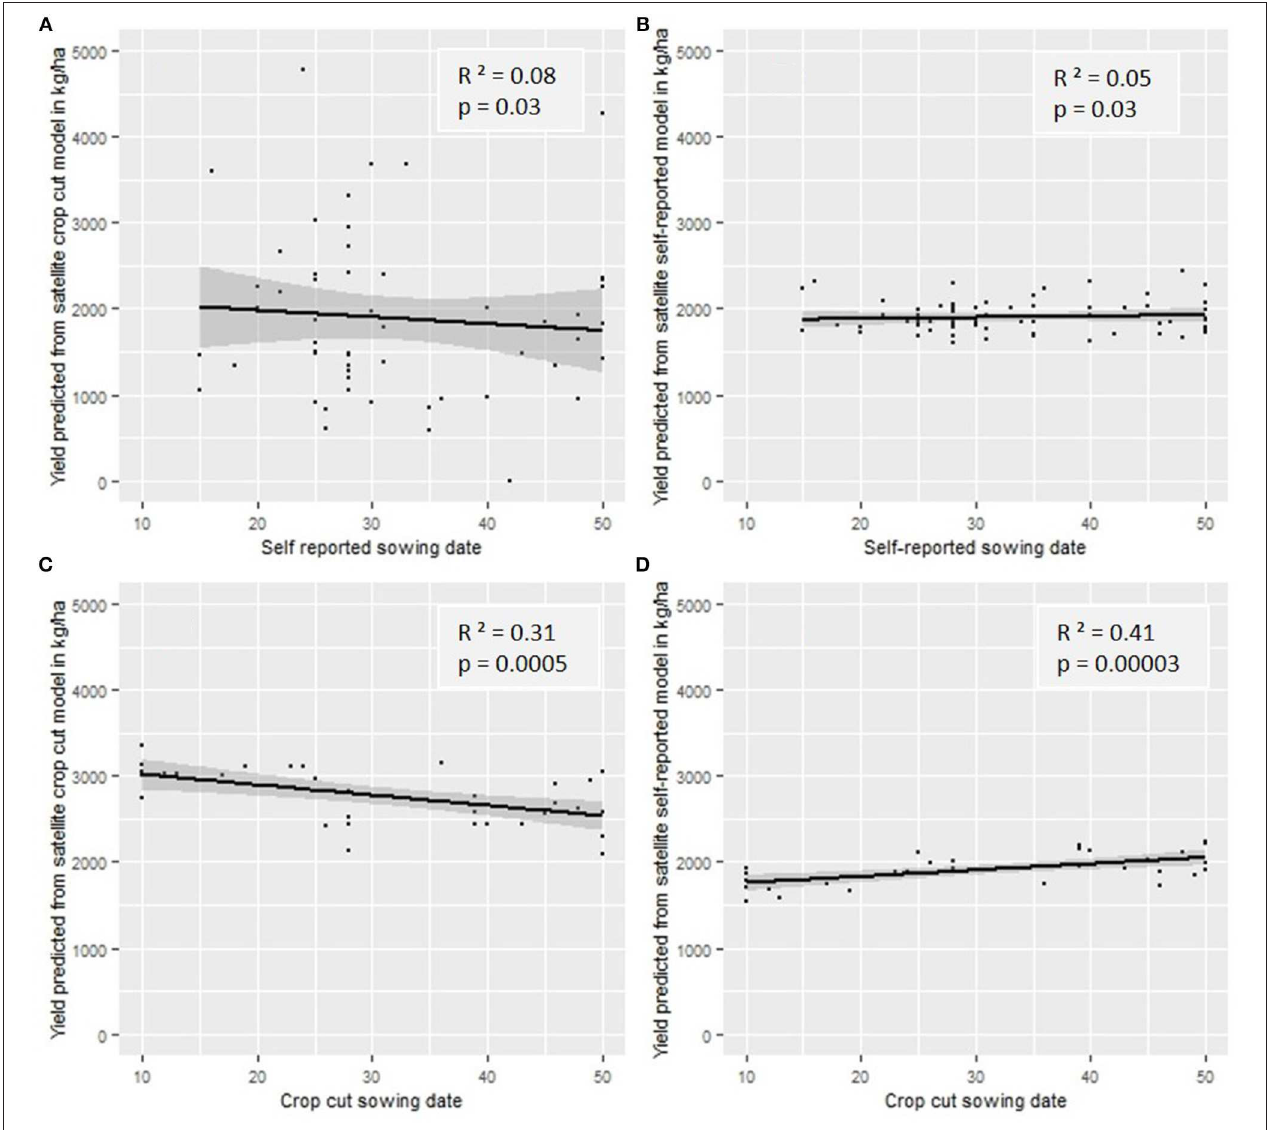
FIGURE 5 | Sowing date vs. yield for self-reported calibrated and crop cut calibrated yield estimation models. We present four panels: sowing date vs. yield predicted from satellite data calibrated using crop cut data (A,C) , and sowing date vs. yield predicted from satellite data calibrated using self-reported data (B,D) . The R 2 and p values from each linear regression are reported along with standard error (represented by the gray band around each regression